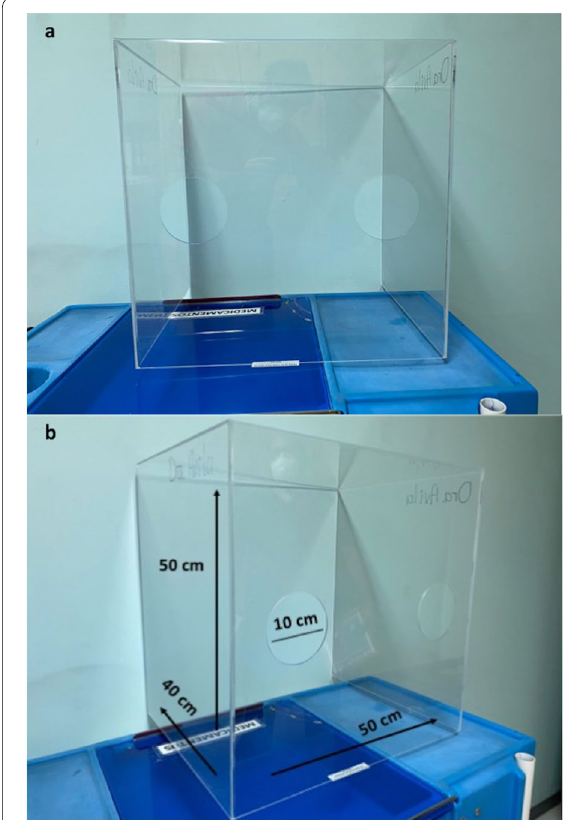
Fig. 2 A , B Dimensions of aerosol‑box used as barrier protection in the approach to the airway in the Hospital Central Sur de Alta Especialidad, Mexico